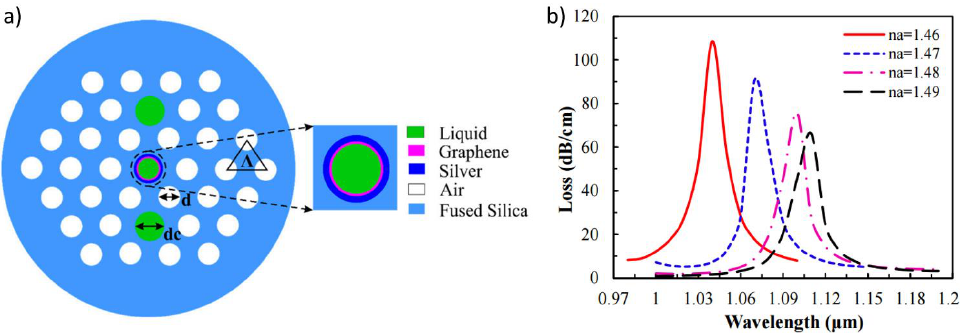
Figure 7. ( a ) Cross-section of the SPR-based sensor proposed in [91]. ( b ) Loss spectrum of the